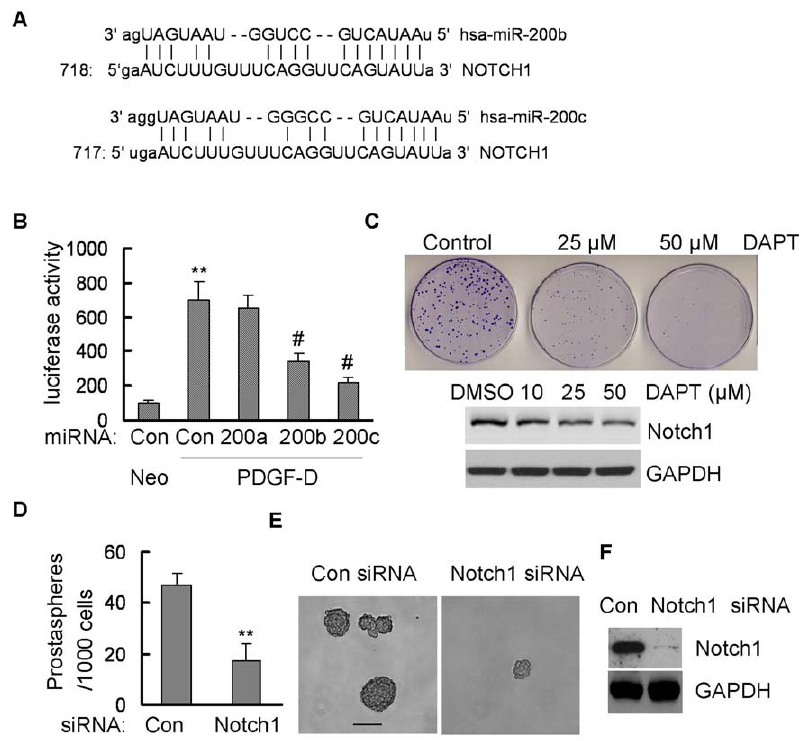
Figure 5. Inactivation of Notch1 repressed the colonogenic and prostasphere-forming capacity. (A) Conserved, predicted binding sites for the seed sequences of miR-200b and mir-200c in the 3 9 UTR of Notch1 mRNA. (B) MiR-200b and miR-200c inhibited the Notch1 3 9 UTR luciferase activity. **, p , 0.01 compared to Neo control cells; # , p , 0.01 compared to PDGF-D control cells. (C) DAPT treatment, a c -secretase inhibitor, reduced the clonogenic ability in PC3 PDGF-D cells (upper panel).Western Blot showing that DAPT treatment reduced active form of Notch1 in dose- dependent manner (lower panel). (D) and (E) showing that transfection of Notch1 siRNA after 9 days repressed the prostasphere-forming capacity in PC3 PDGF-D cells (Bar:100 m m), which is consistent with downregulation of Notch1 expression (F). **, p , 0.01 compared to control. (Neo: PC3 Neo cells, PDGF-D: PC3 PDGF-D cells, Con: control, 200a: pre-miR-200a, 200b: pre-miR-200b, 200c: pre-miR-200c).